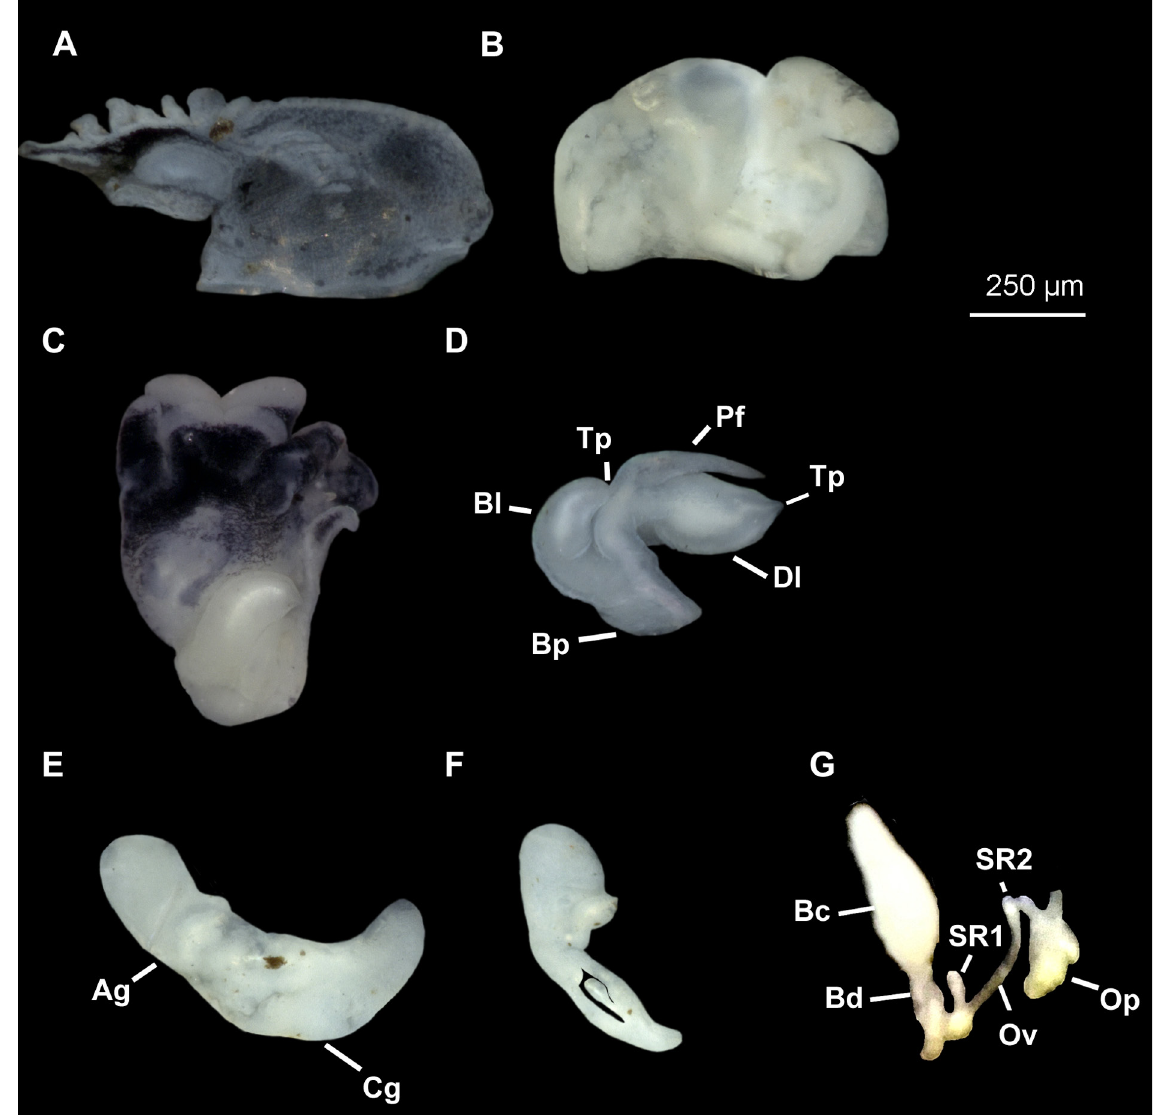
Fig. 8. Anatomy of Biserta putealis gen. et sp. nov. (paratypes, UGSB 17664). A . Ctenidium and osphradium. B . Stomach. C . Head of male and penis. D . Detail of penis and penis lobes. E . Pallial oviduct. F . Bursa copulatrix and seminal receptacles. G . Ditto, observed by transmitted light. Anatomical abbreviations explained in the